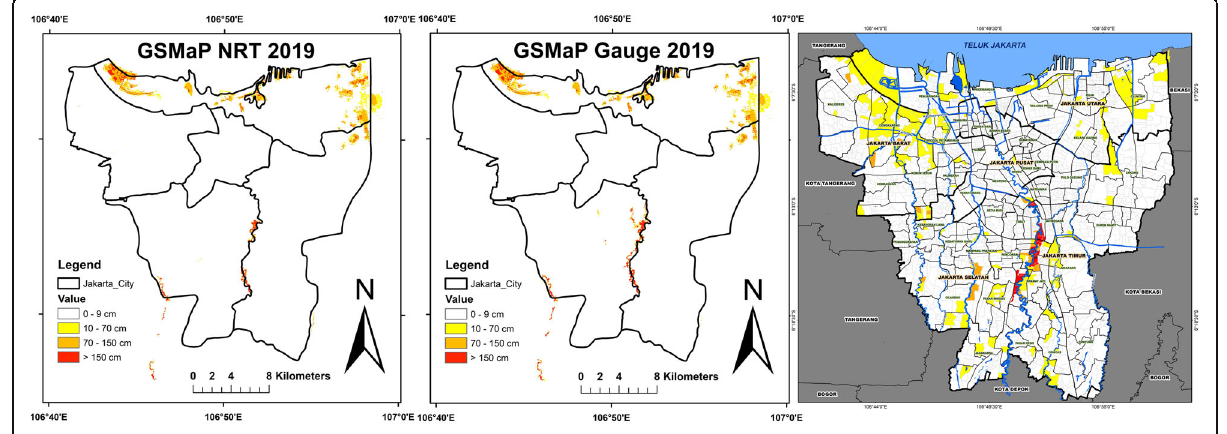
Fig. 16 Flood inundation comparisons for flood event of